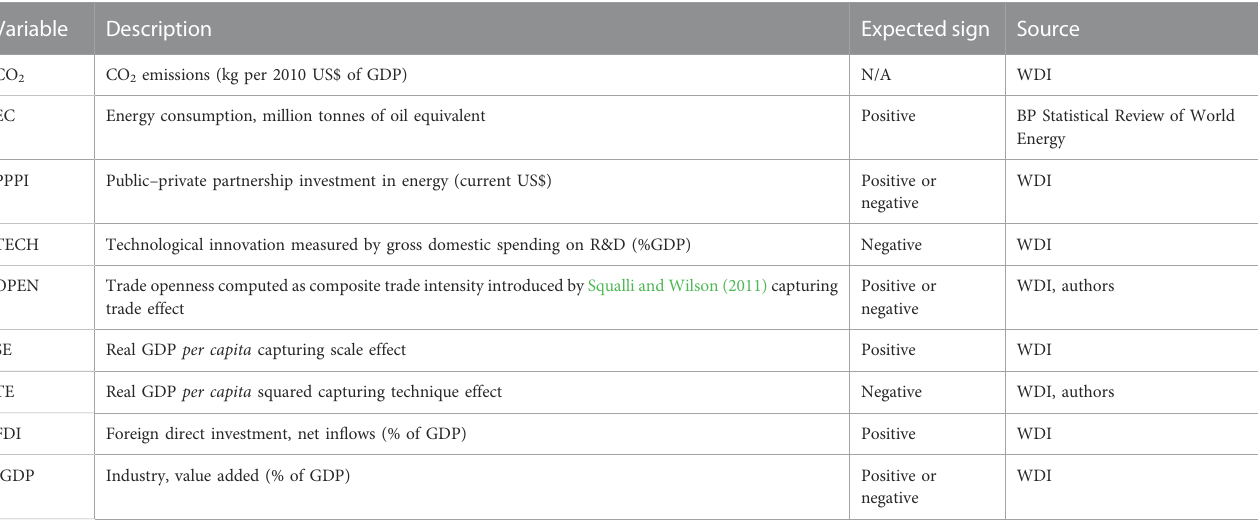
TABLE 2 De fi nition of variables and data